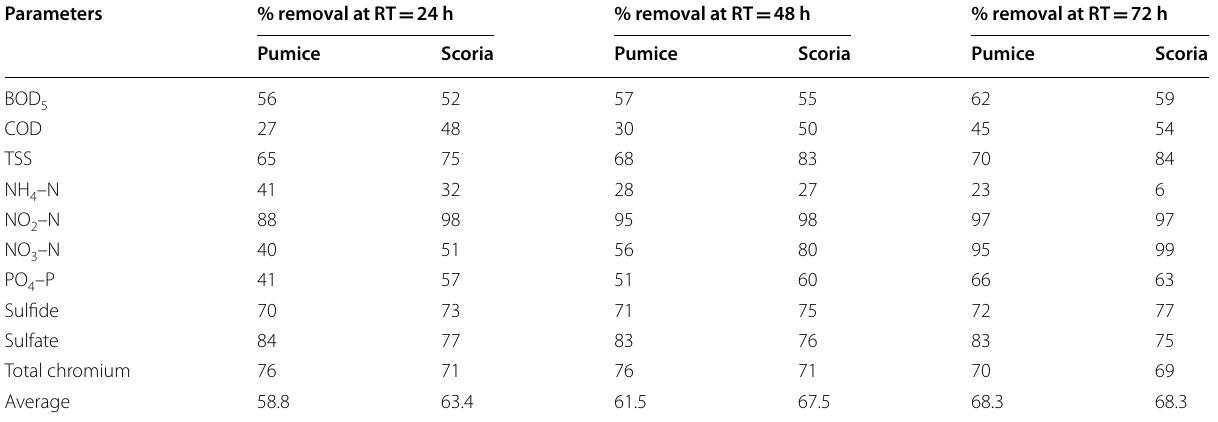
Table 7 Comparison of scoria and pumice filter media efficiency in tannery wastewater treatment Parameters